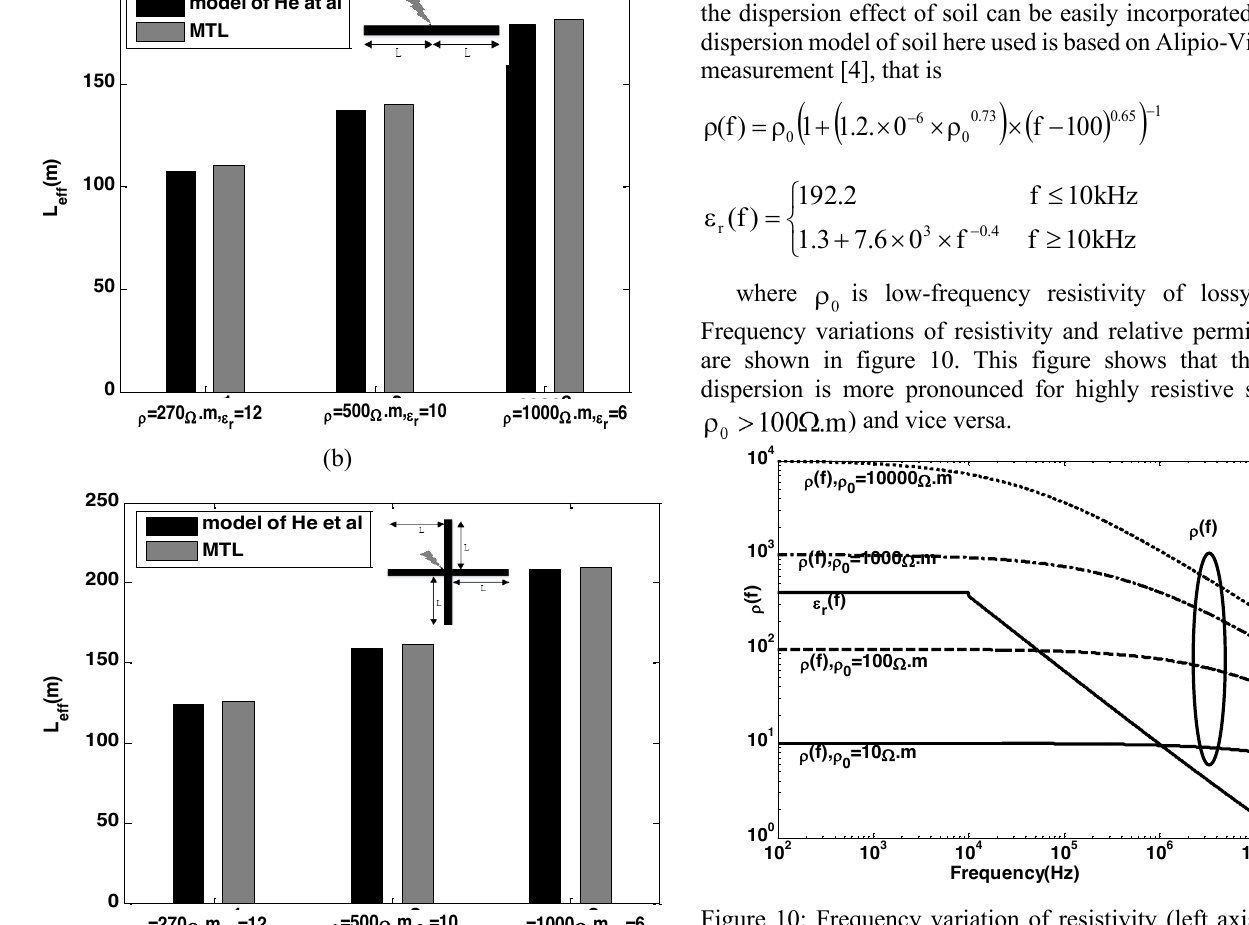
Figure 10: Frequency variation of resistivity (left axis) and relative permittivity (right axis) based on Alipio-Visacro measurement